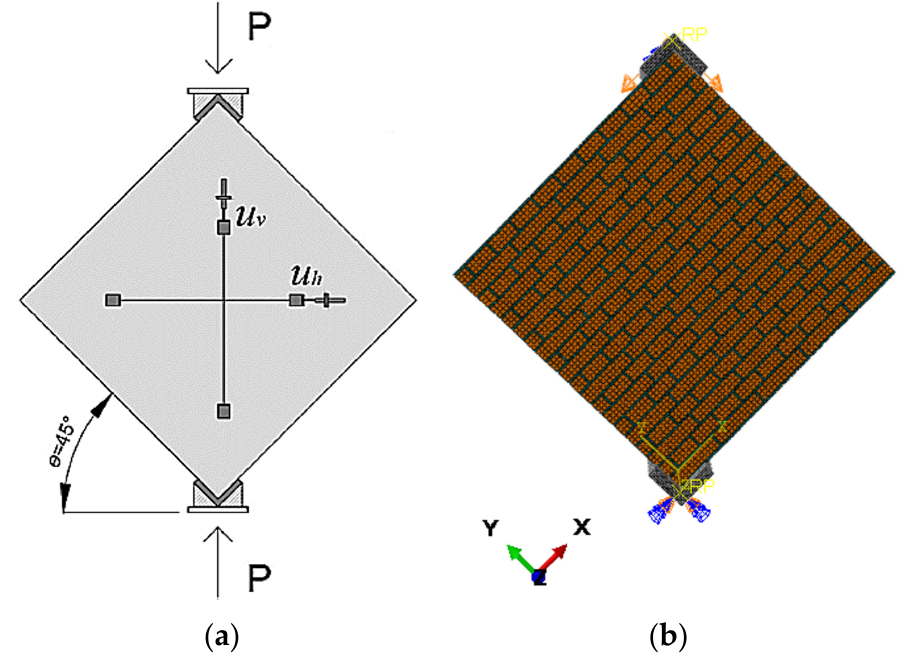
Figure 6. ( a ) DC test set-up; ( b ) FE model of the wall with load and boundary